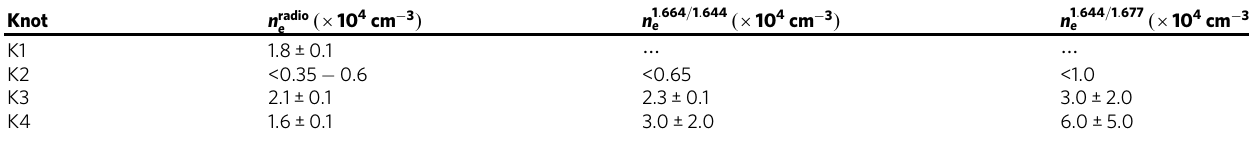
Table 3 Electron density ( n e ) for the various knots